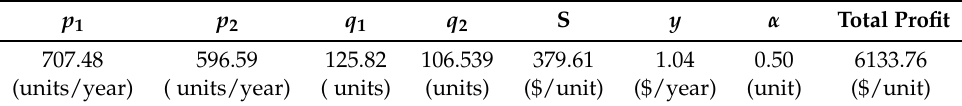
Table 5. Optimum results of Example 2.